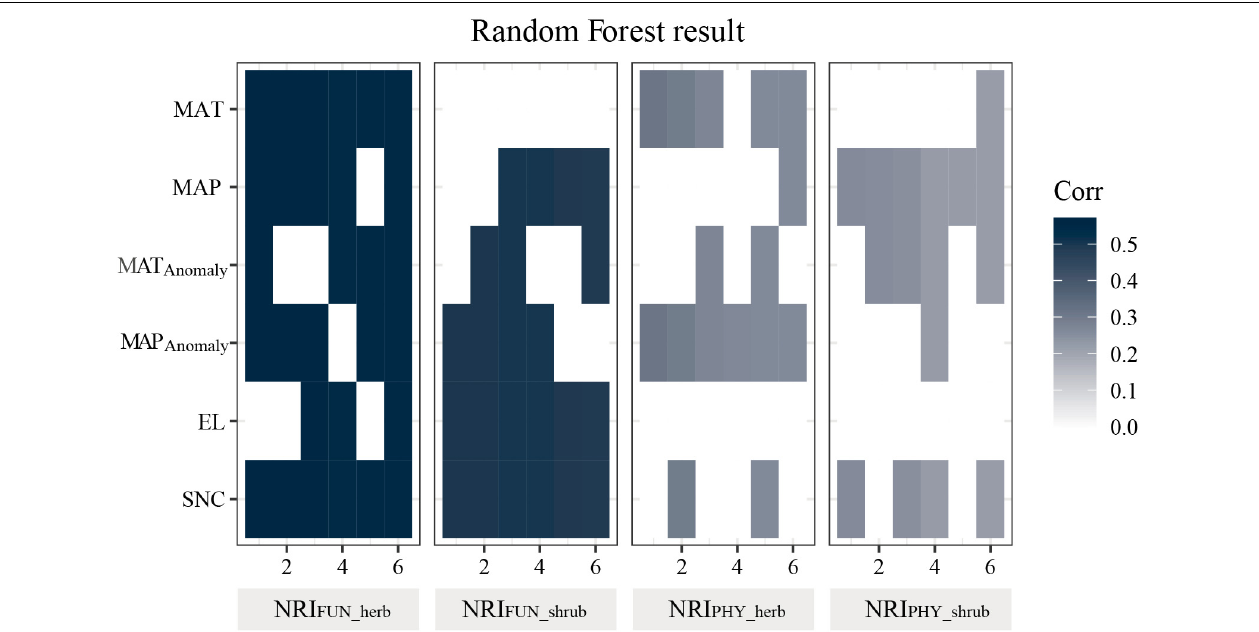
FIGURE 3 | Six combinations of the variables with the highest explanatory power for the community structure in the Random Forest modeling. Each row represents a variable. Blue plaque indicates the environmental factors that existed in the combinations. NRI FUN_herb , functional structure of herb; NRI FUN_shrub , functional structure of shrub; NRI PHY_herb , phylogenetic structure of herb; NRI PHY_shrub , phylogenetic structure of shrub. EL, elevation; MAT, mean annual temperature; MAT Anomaly means MAT anomaly; MAP, mean annual precipitation; MAP Anomaly , MAP anomaly; SNC, soil nitrogen